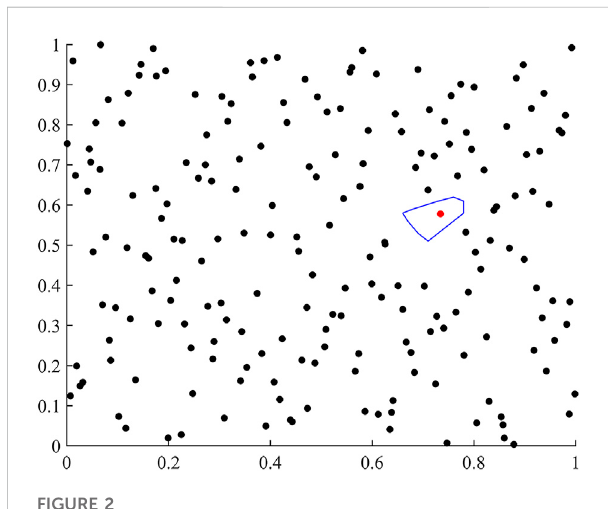
FIGURE 2 Diagram of test set shape parameter selection